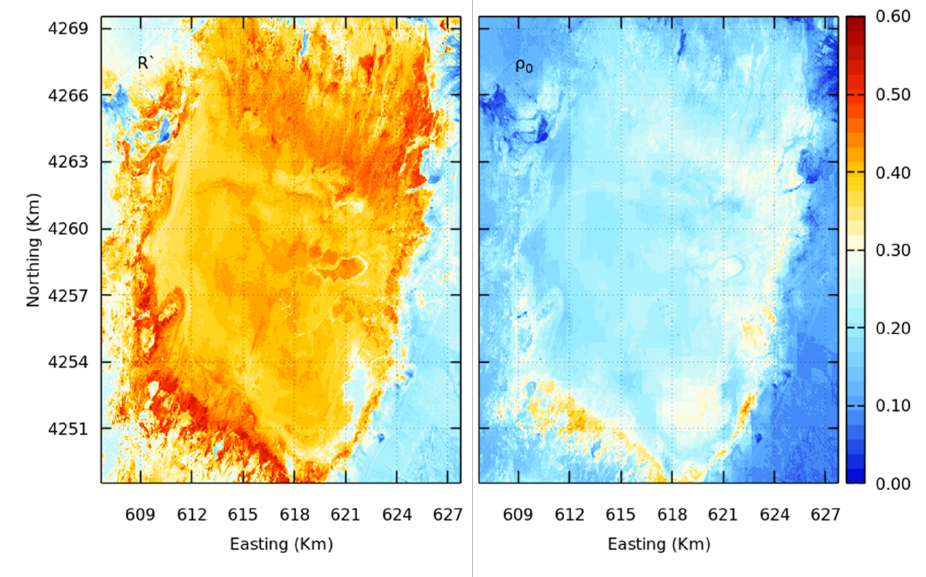
Figure 8. Left panel shows the Landsat5-TM derived atmospherically corrected reflectance R’ (14 July 2009) in the red band. The right panel shows the ρ (cid:48) resolution from the inversion of the mRPV model assuming a nadir view and the actual sun position of θ s of 28.2 ◦ during the Landsat overpass. Parameters k (cid:48) and b (cid:48) bilinearly interpolated during the inversion process (MISR data were taken from MISR2ASLS for 15 July